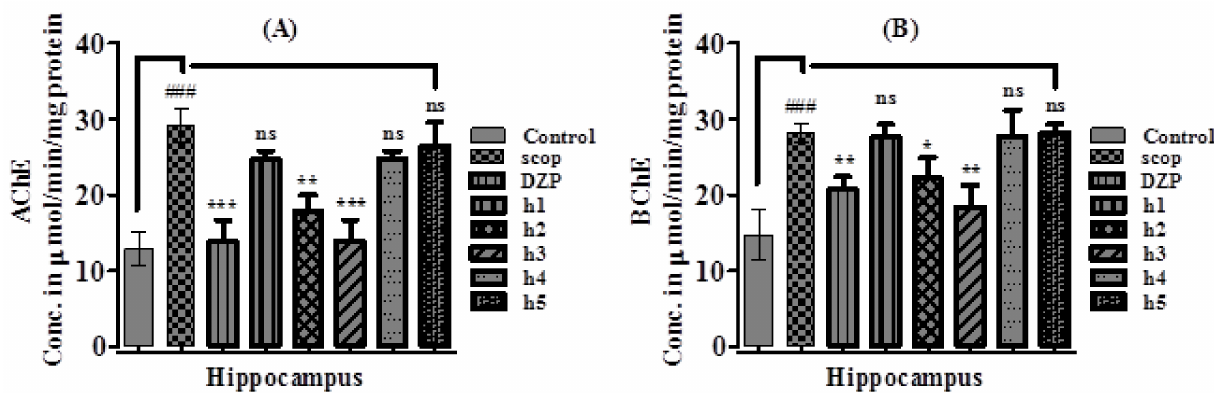
Figure 5. Ex vivo anticholinesterase effect of synthesized curcumin analogs ( h1 – h5 ) in AChE ( A ) and BChE ( B ) in the hippocampus region of mouse brain versus the scopolamine-treated group. All values are presented as mean ± SEM ( n = 6), ### p < 0.001 vs. normal control. Significantly different values are with reference to the scopolamine-treated group; p -value <0.001, < 0.01, < 0.05 are expressed as ***, **, and *, respectively. One-way ANOVA followed by Dunnett’s multiple comparison tests was